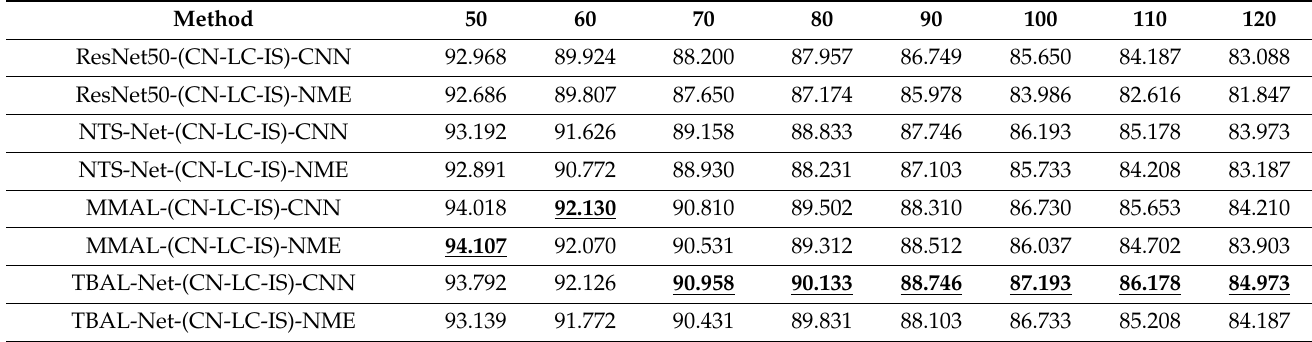
Table 5. Performance (Top-1 Accuracy %) on CUB-200-2011 as the number of classes increases from 50 to 120.